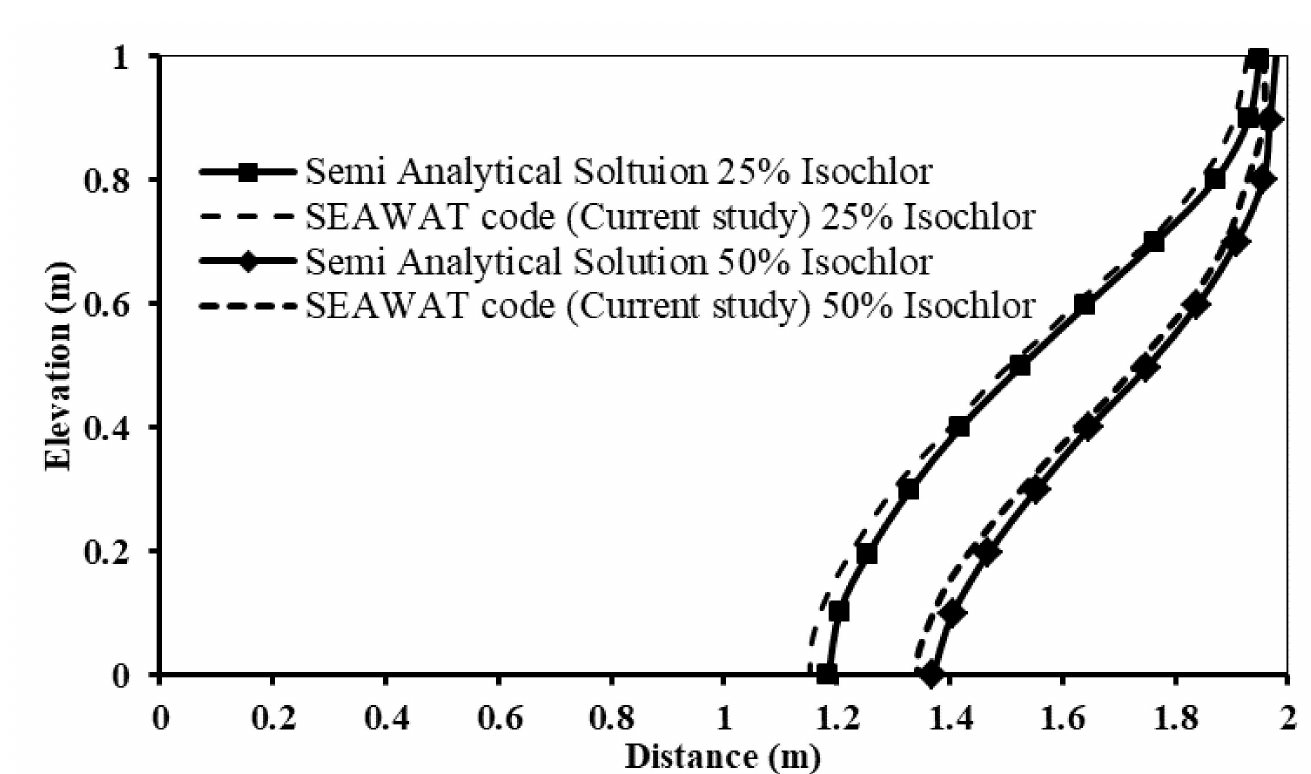
Figure 3. Comparison between saltwater intrusion wedge for SEAWAT code and the semi-analytical solution of the Henry saltwater